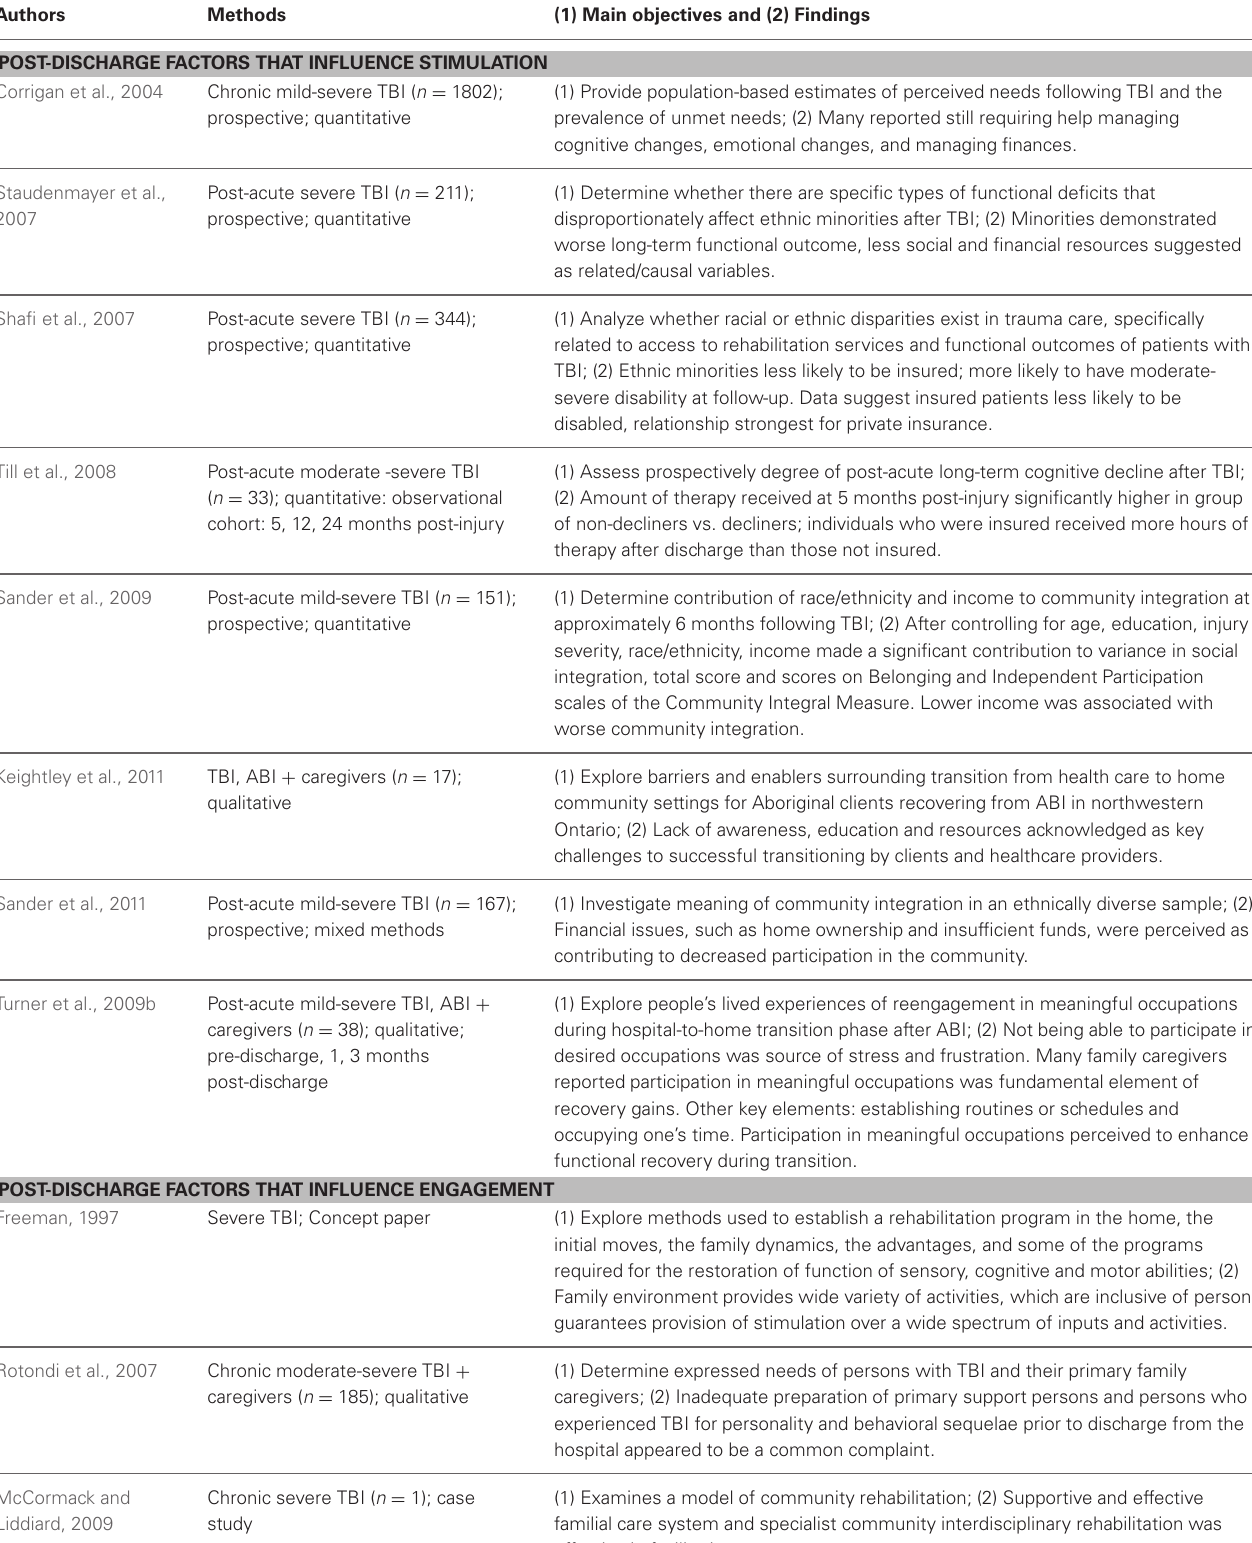
Table 3 | Detailed summary of articles included in “Post-discharge experiences and EE” scoping